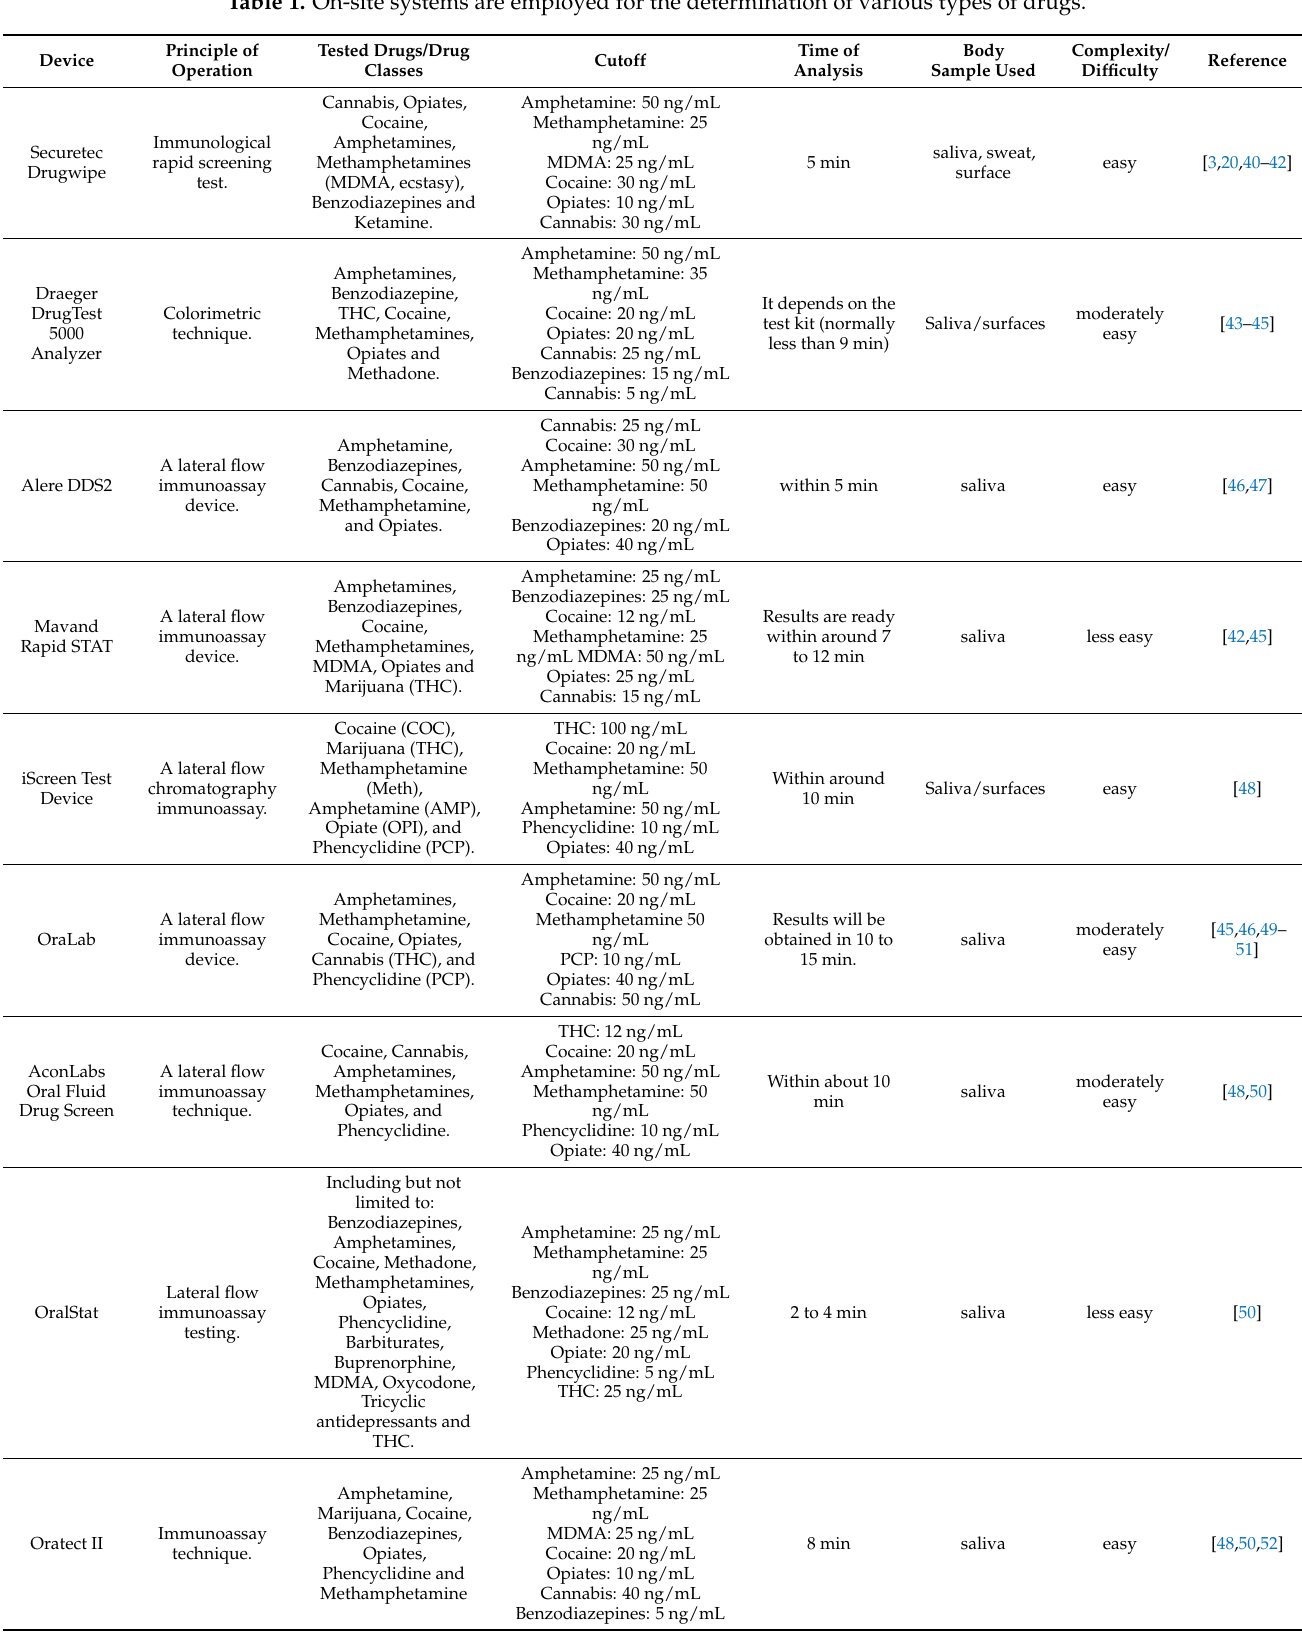
Table 1. On-site systems are employed for the determination of various types of drugs.